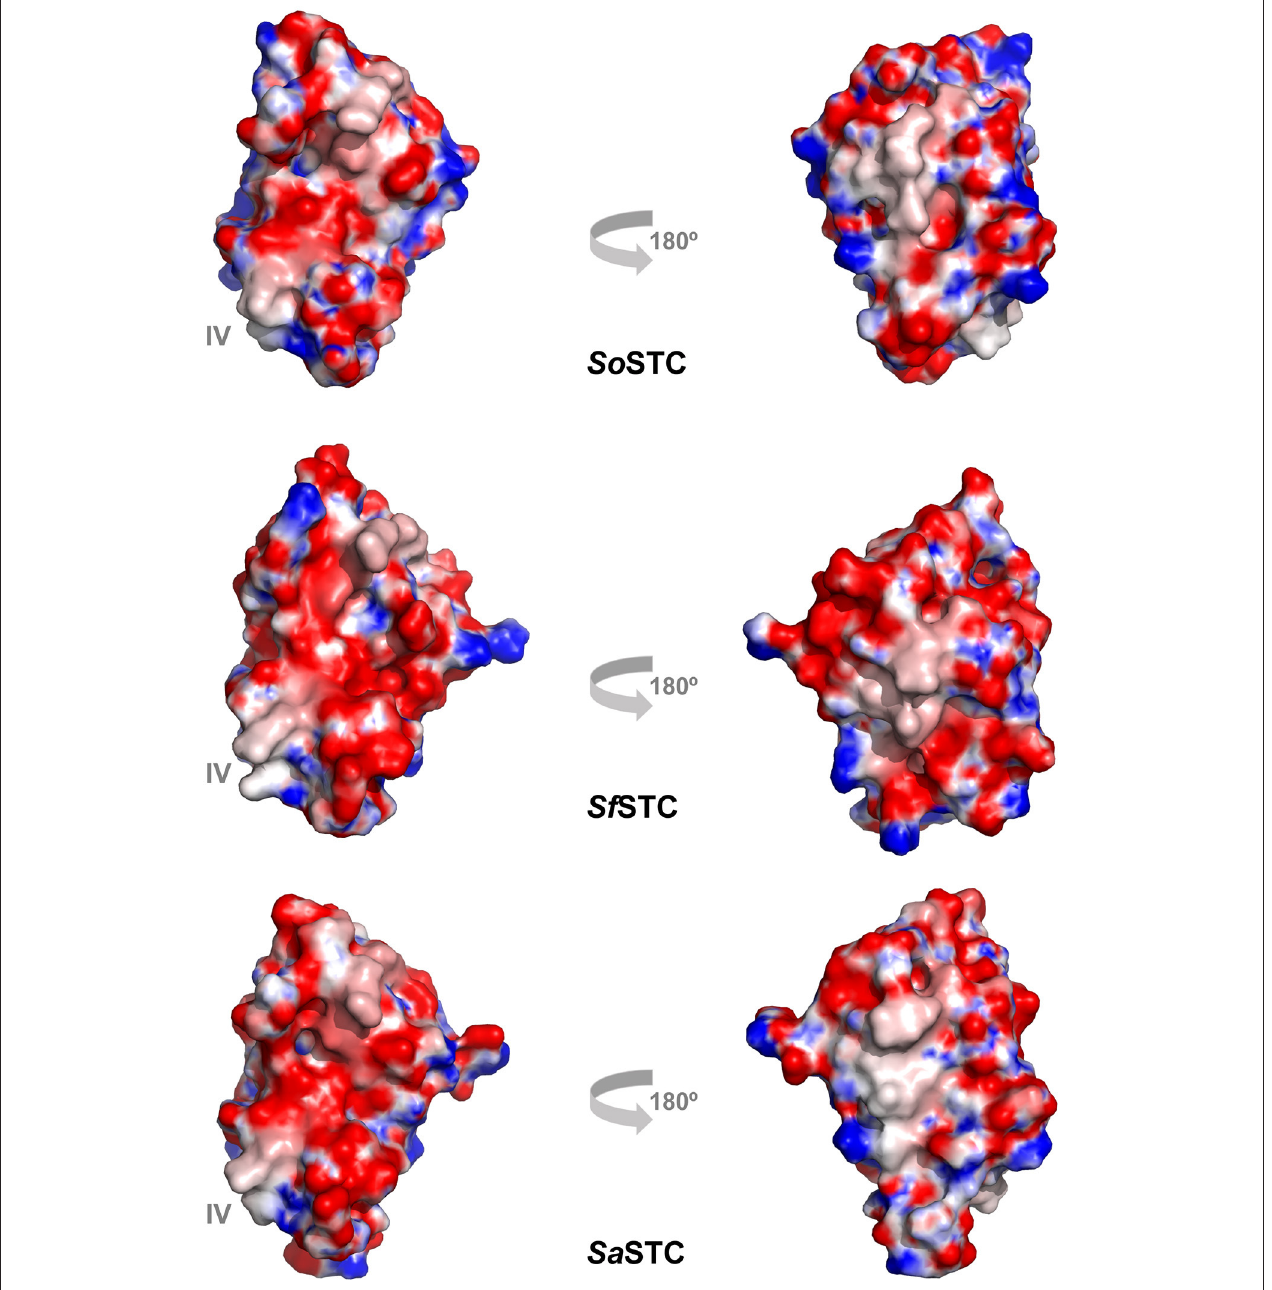
FIGURE 6 | Electrostatic surface potential ( − 10 to + 10 kT/e) of So STC (PDB ID 1M1P), Sf STC (PDB ID 2K3V) and of Sa STC (PDB ID 6HR0). The surfaces are shown in the same orientation as the ribbon representation of Sa STC in Figure 4 , and were calculated using the APBS plugin in Pymol (Baker et al.,